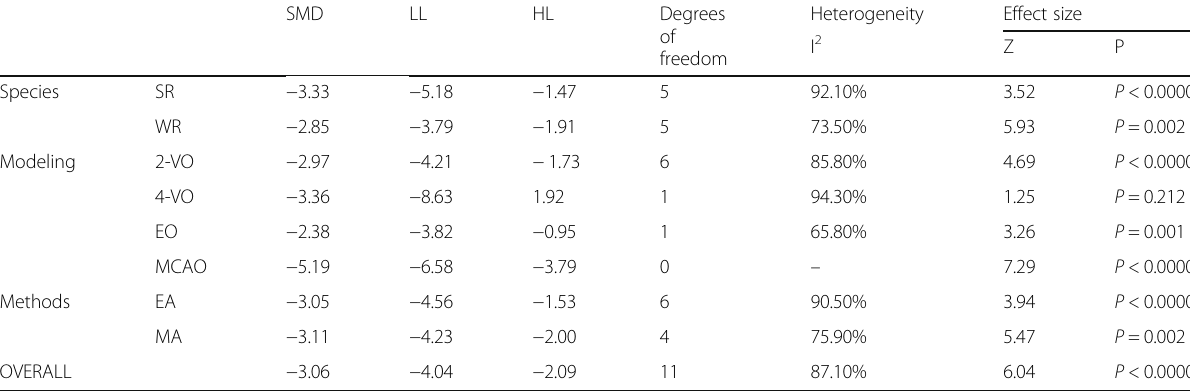
Table 3 Subgroup analysis for the effect of acupuncture on reducing escape latency